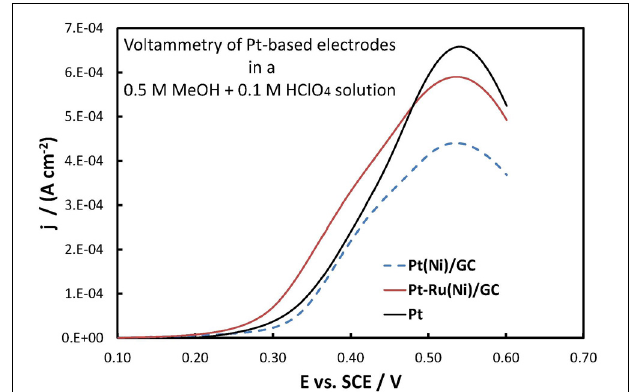
FIGURE 8 | Voltammogram of a Pt(Ni)/GC electrode in a deaerated 0.1M HClO 4 solution at 500mV s − 1 , following the procedure for CO monolayer adsorption and subsequent oxidation described in section Electrochemical characterization of coatings. The scan was initiated at + 0.20V toward more positive potentials.